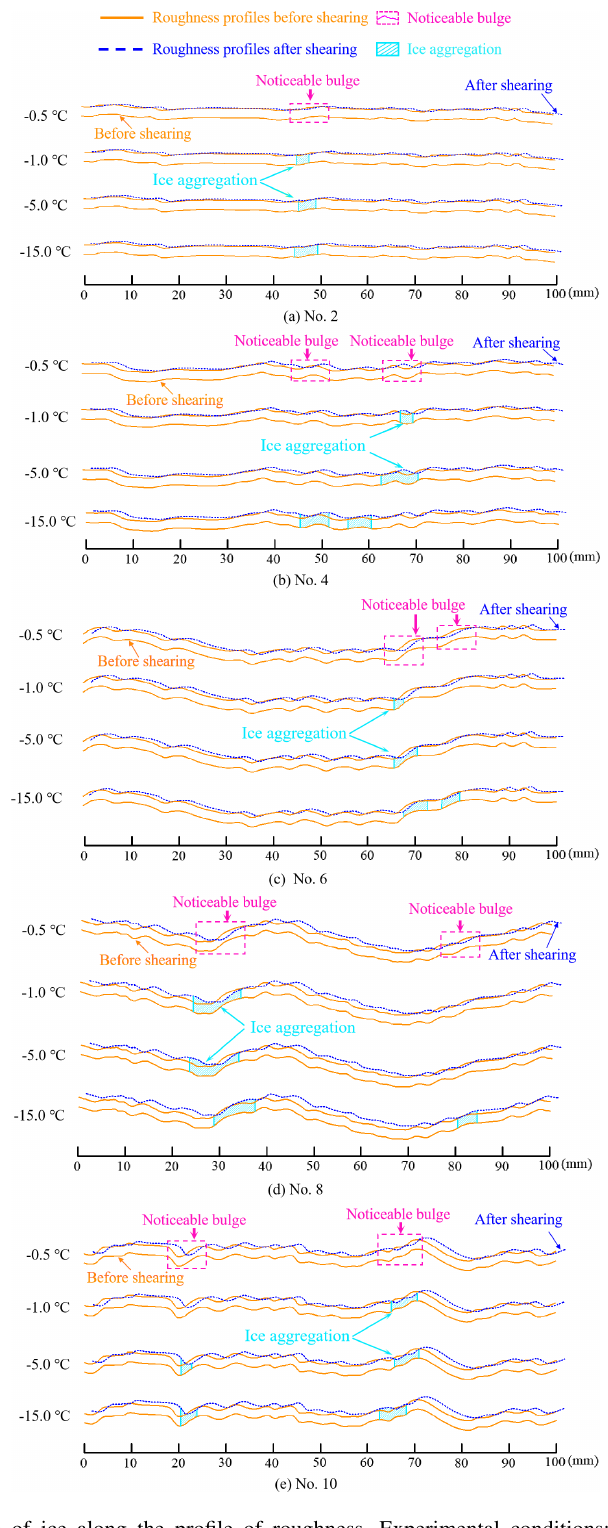
Figure 7. Shear aggregation areas of ice along the profile of roughness. Experimental conditions: v = 0.2mmmin − 1 , d = 2mm and σ n = 0.5MPa. Some blue profiles (dotted curves) are located under the orange profiles (solid curves) after shearing, which means the width of joints decreases. Generally, the reduction in joint width occurs before some bulges, and the rupture ice aggregates before these bulges. The bulges causing the reduction in joint width and aggregation of ice are called noticeable bulges. The noticeable bulges have larger inclination angles, and they are far away from the joint